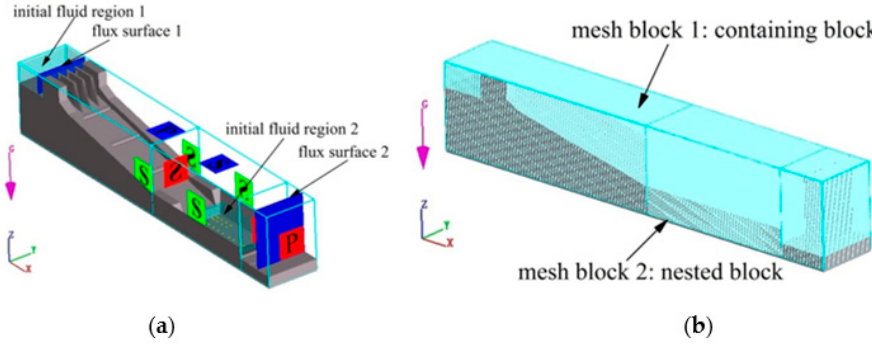
Figure 4. 3D simulation model: ( a ) Boundary conditions; ( b ) Grid mesh.